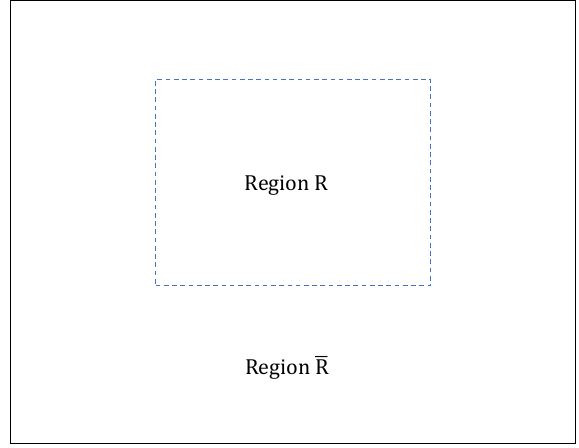
Figure 3 . A disk away from the PB of a